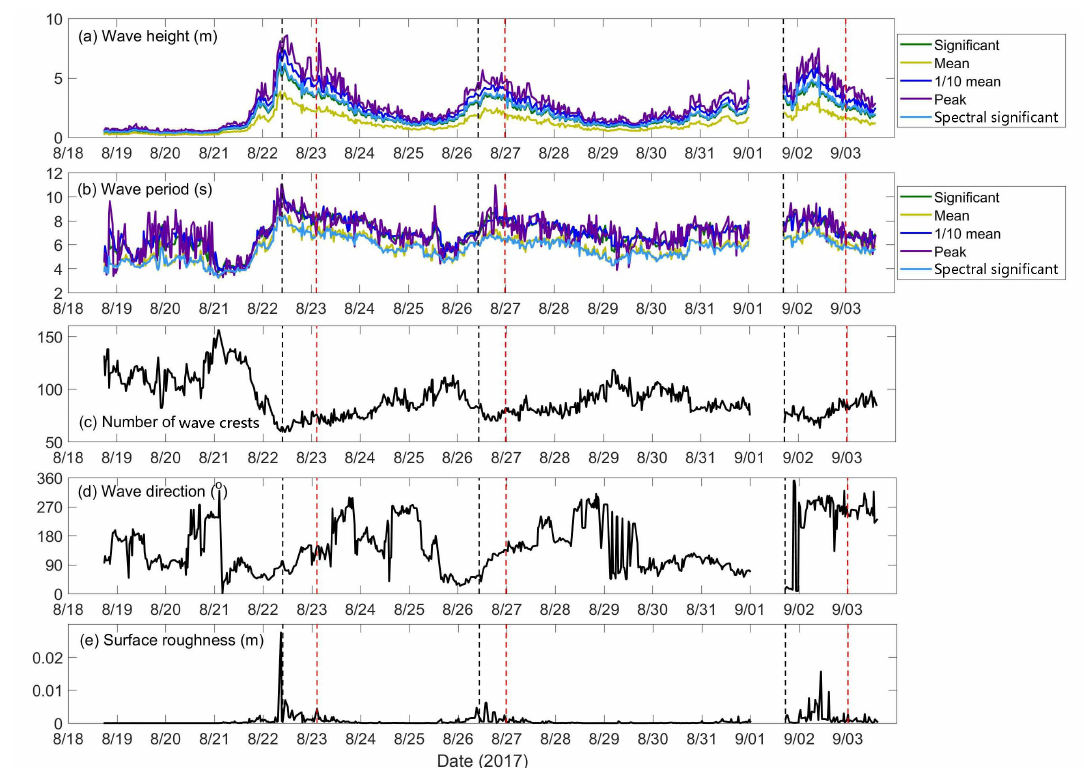
Figure 3. Wave parameters from the wave glider observations: ( a ) wave height; ( b ) wave period; ( c ) number of wave crests in a time interval of 1024 s; ( d ) wave direction; and ( e ) ocean surface roughness. The black dashed line represents the time when the TC is closest to the wave glider. The red dashed line shows the time when the TC is strongest during the observation.